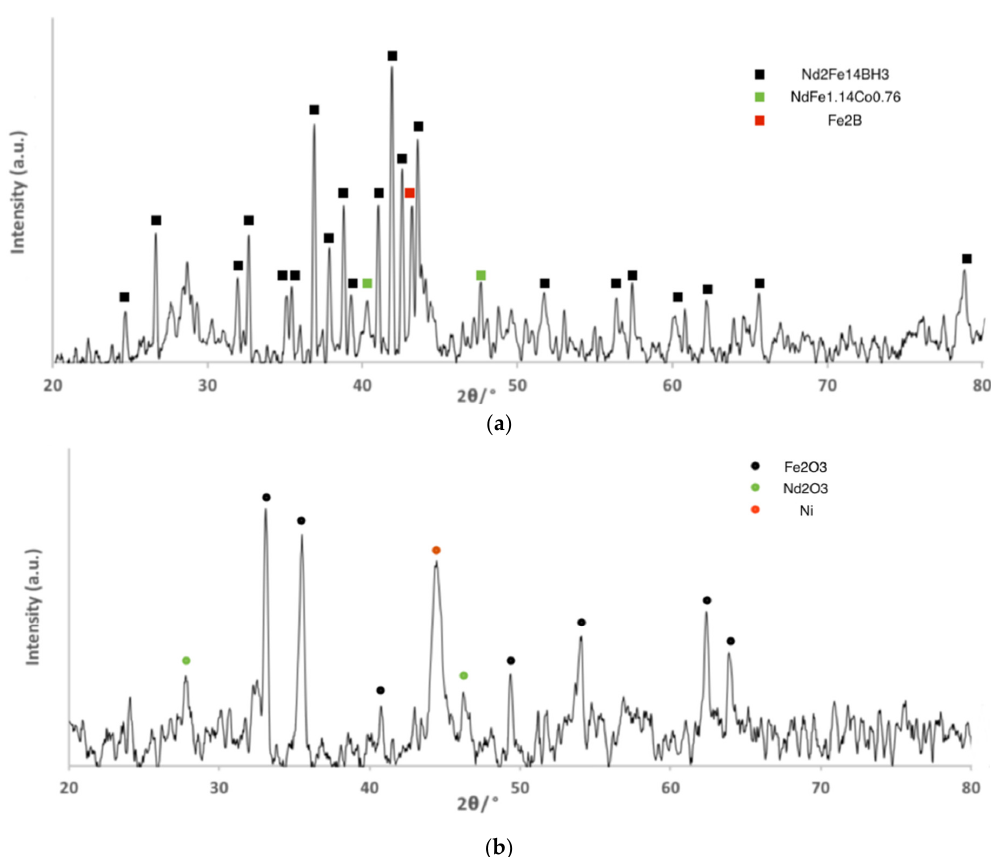
Figure 2. XRD pattern of the ( a ) hydrogen decrepitated NdFeB powder and ( b ) roasted NdFeB powder.